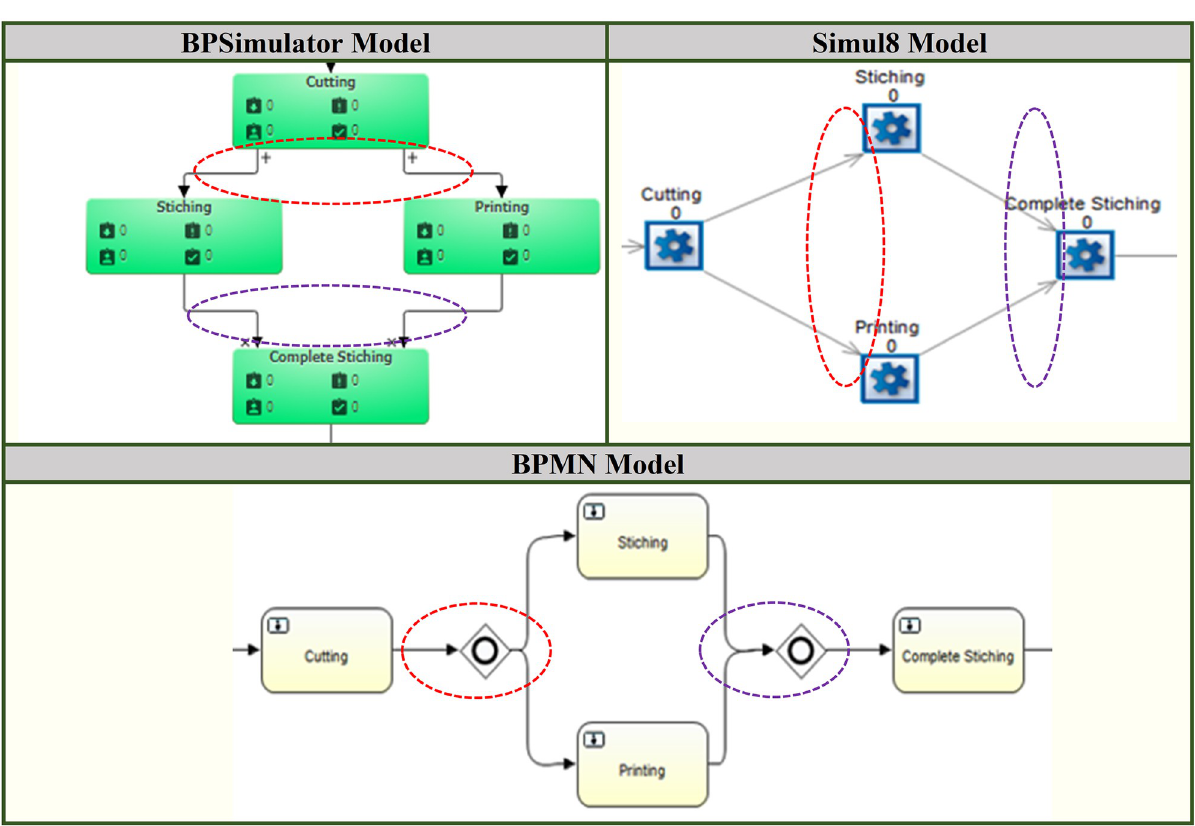
Fig 14. Part of shirt manufacturing model shows red and purple dotted oval in BPSimulator and Simul8 are converted to parallel gateways opening and closing in BPMN